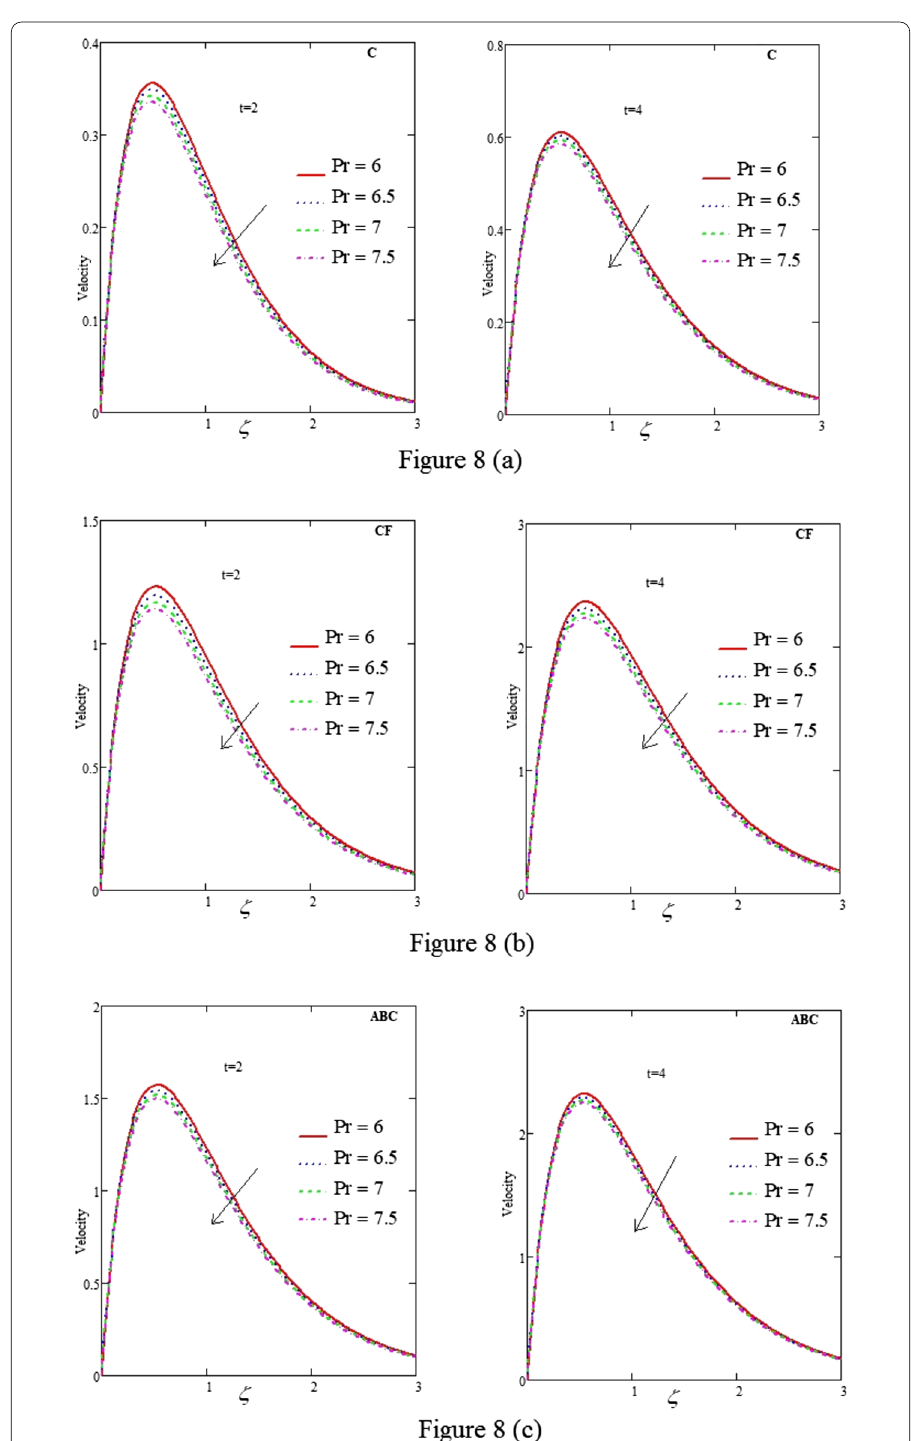
Figure 8 ( a , b , c ). Velocity curves belonging to C, CF and ABC for various values of Pr, where γ = 0.1, Gr = 6, λ = 0.2, Sc = 8, Gm = 8 and M =